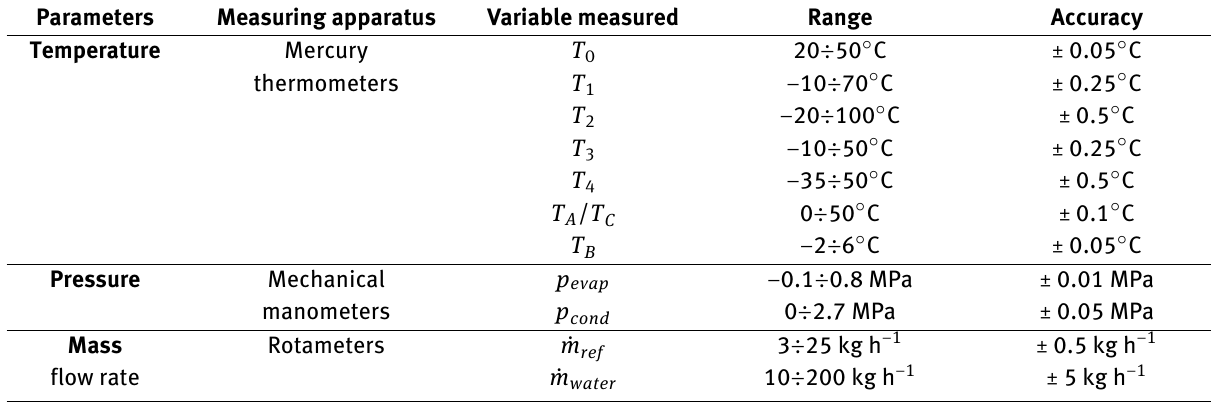
Table 5: Summary table with the characteristics of the instrumentation used in the experimental set-up.